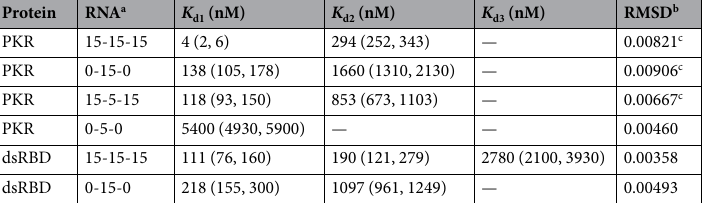
Table 2. Sedimentation velocity analysis of PKR and dsRBD binding to ss-dsRNAs. Parameters obtained by global nonlinear least square analysis of the sedimentation velocity data. The values in parentheses represent the 95% joint confidence intervals obtained using the F-statistic. a The three numbers indicate the length of the 5 ′ -tail (nt), the stem (bp), and the 3 ′ -tail (nt), respectively. Each of the RNAs contains a 5 ′ -ppp and a tetraloop capping the stem sequence. b Root mean square deviation in absorbance. c Data from ref.